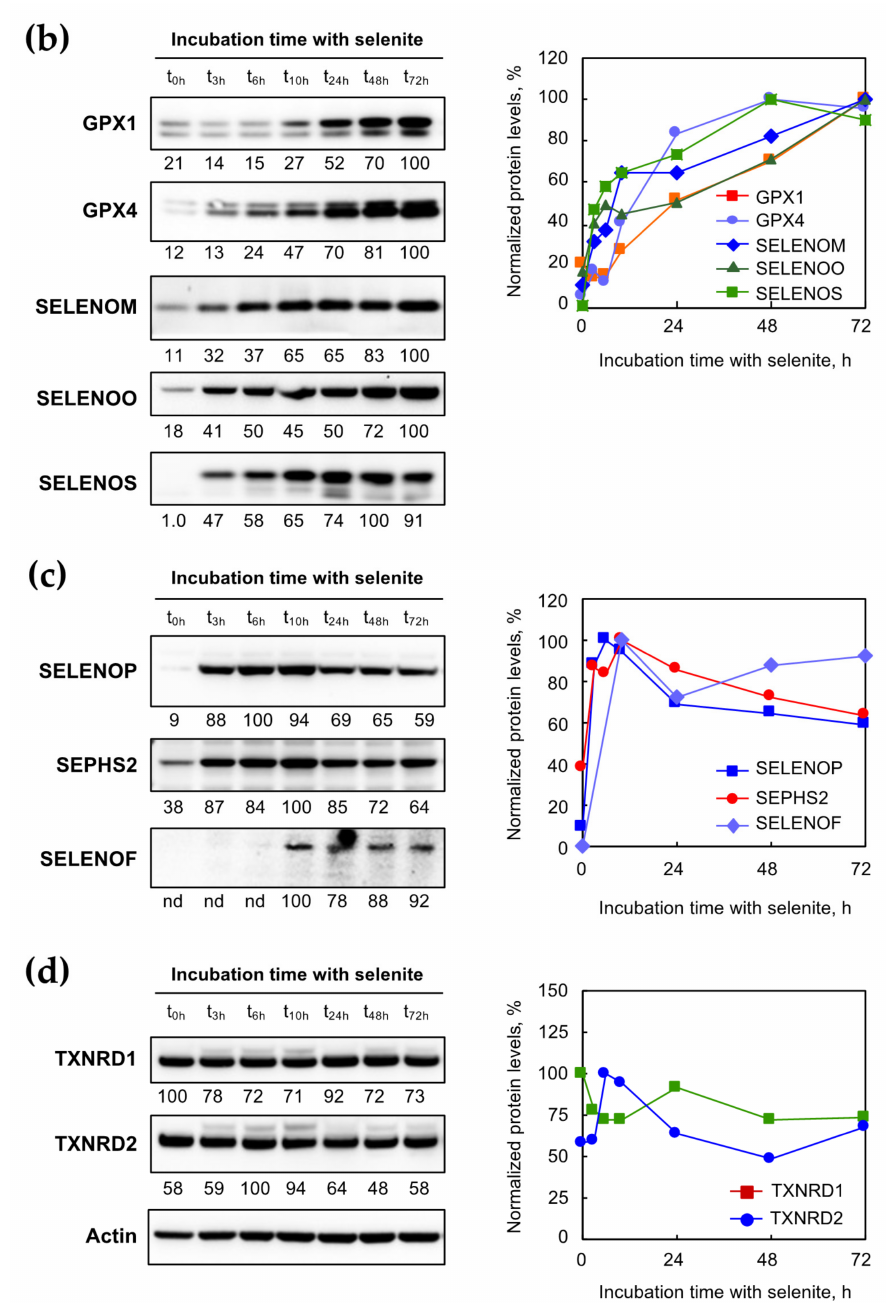
Figure 5. Time-course analysis of selenoprotein expression in medium containing 100 nM 77 Se. ( a ) The stimulation of selenocysteine insertion in response to selenium addition is not dependent on the nature of the SECIS element. The two cell lines containing Luc UGA/GPX1 or Luc UGA/GPX4 construct were grown for three days in a Dpl medium prior to being plated in medium containing 100 nM of selenium and harvested at a defined time as described in Figure 4. Cell extracts were analyzed for luciferase activities and Sec efficiency was expressed relative to the one measured at t 0 , set as 1. The HEK293 cell extracts labeled with 77 Se (similar to Figure 4) were analyzed by western immunobotting for the presence of selenoproteins GPX1, GPX4, SELENOM, SELENOO, and SELENOS ( b ), SELENOP, SEPHS2, and SELENOF ( c ), and TXNRD1, and TXNRD2 ( d ). Relative quantification of individual selenoprotein over actin is indicated at the bottom of the corresponding immunoblot, with maximum intensity set at 100. The quantification results are also represented as a function of time and sorted into three classes. The optimal selenoprotein expression was reached either after 48 h (top-right panel) or before 10 h (middle-right panel). Alternatively, the expression of selenoprotein can be stable with time (bottom-right